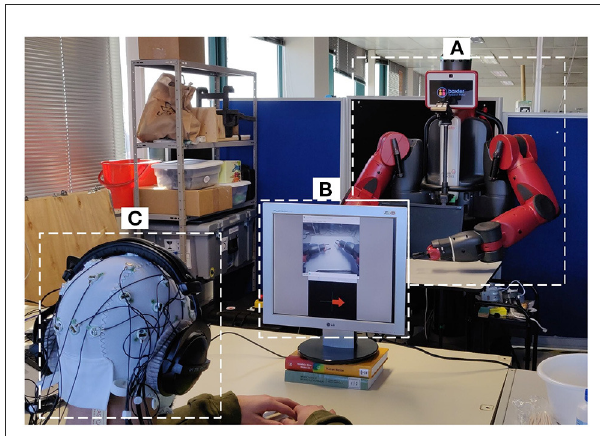
FIGURE2 Experimental setup. (A) The Baxter robot; (B) screen for delivering the visual simulations to the user for the first-person perspective; (C) participant with the 32 electrode EEG system and headphones for auditory stimulation and impeding outside